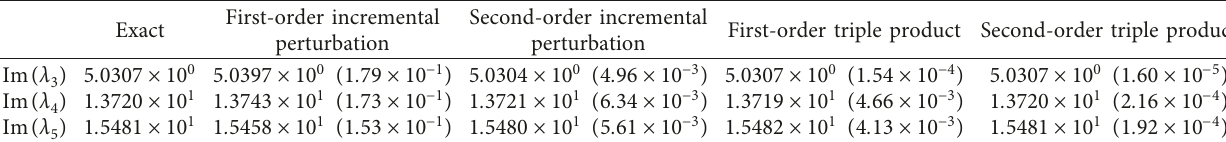
7 for σ 0 . 5. (cid:31) (cid:31)